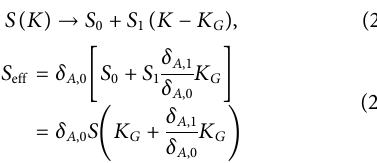
FIGURE 2 Plot showing the ratio of effective to nuclear S-factor, R S (cid:2) S ( T ) / S ( K G ) , for D (D,n) 3 He at varying levels of eff approximation given by S ( N ) eff , ϵ as de fi ned in Eq. 15. The black dashed line shows a numerical evaluation of R S using the Bosch- Hale cross section fi t [8]. Literature results [1] have utilised the N = 0 approximation to R s